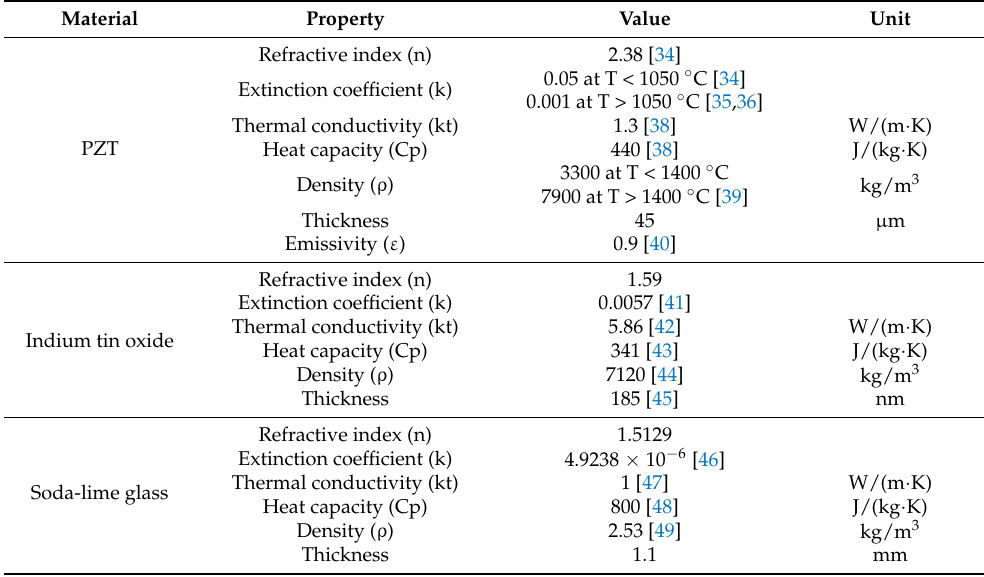
Table 2. Material properties of PZT and substrate used in the finite element